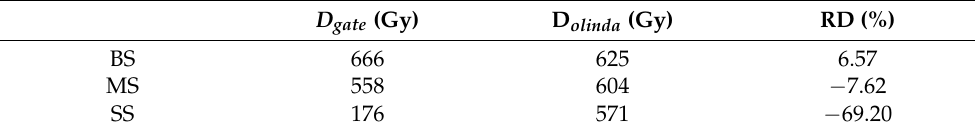
Table 5. Mean absorbed dose values for each sphere, calculated from the Gate image ( D gate ) and from the application of the OLINDA/EXM factors ( D olinda ). The relative difference (RD) is defined as − D olinda . RD = D gate D olinda D gate (Gy) D olinda (Gy)